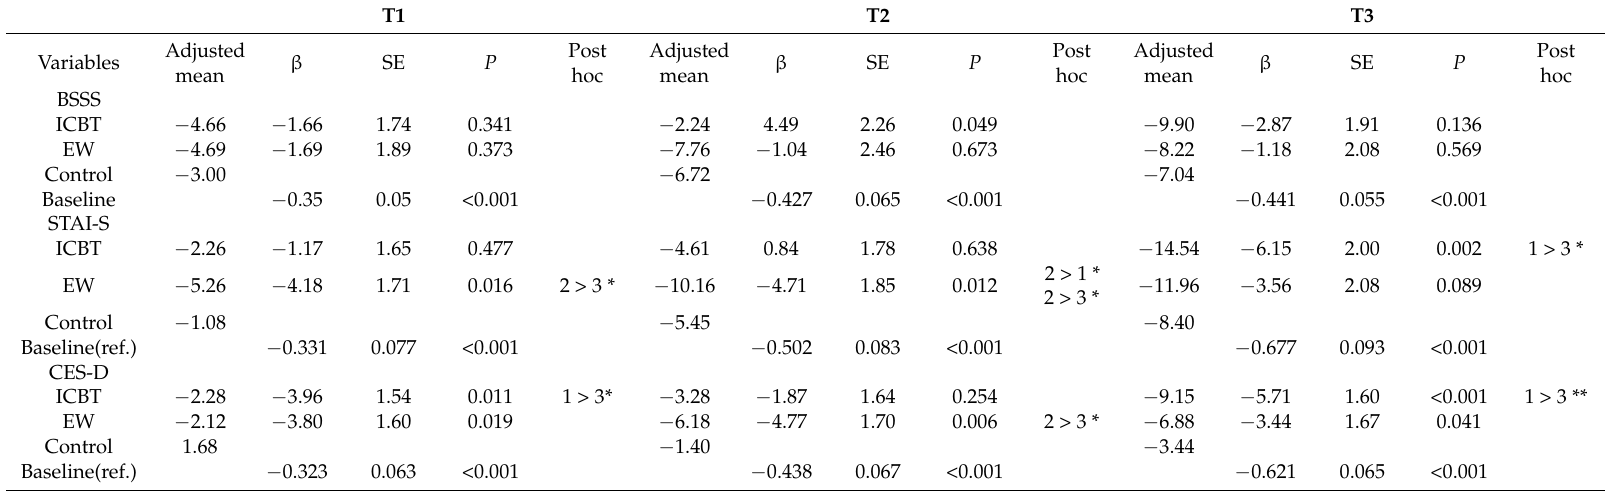
Table 2. ANCOVA results for change in IBS symptoms (BSSS), anxiety (STAI-S), and depression (CES-D) at each time.